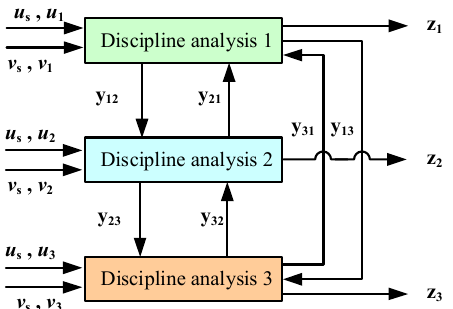
Figure 3. Multidisciplinary analysis under aleatory and epistemic uncertainties. G Num i ( u s , u i , v s , v i , y i ) is the Num th function of reliability constraint of discipline i ; u s is the system shared aleatory design variables in U space; u i is the aleatory design variables of the i th discipline in U space; v s is the system shared epistemic design variables in V space; v i is the epistemic design variables of the i th discipline in V space; y • i , is the state variables input of discipline i from other disciplines, in which i means the number of disciplines; m represents the number of reliability constraint functions of discipline i, while Num means the number of reliability constraint functions of the i th discipline. According to different types of epistemic uncertainties. It can be divided into N E groups, with each group represented by a single elliptical convex model. The state equation of i th discipline is: